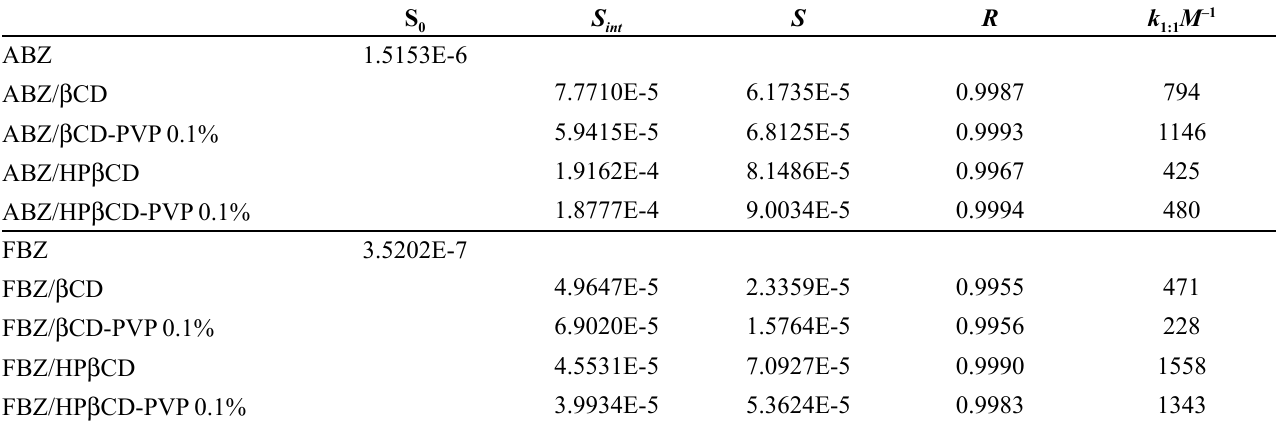
TABLE I - Parameters obtained from the linear regression of the curves of the phase solubility